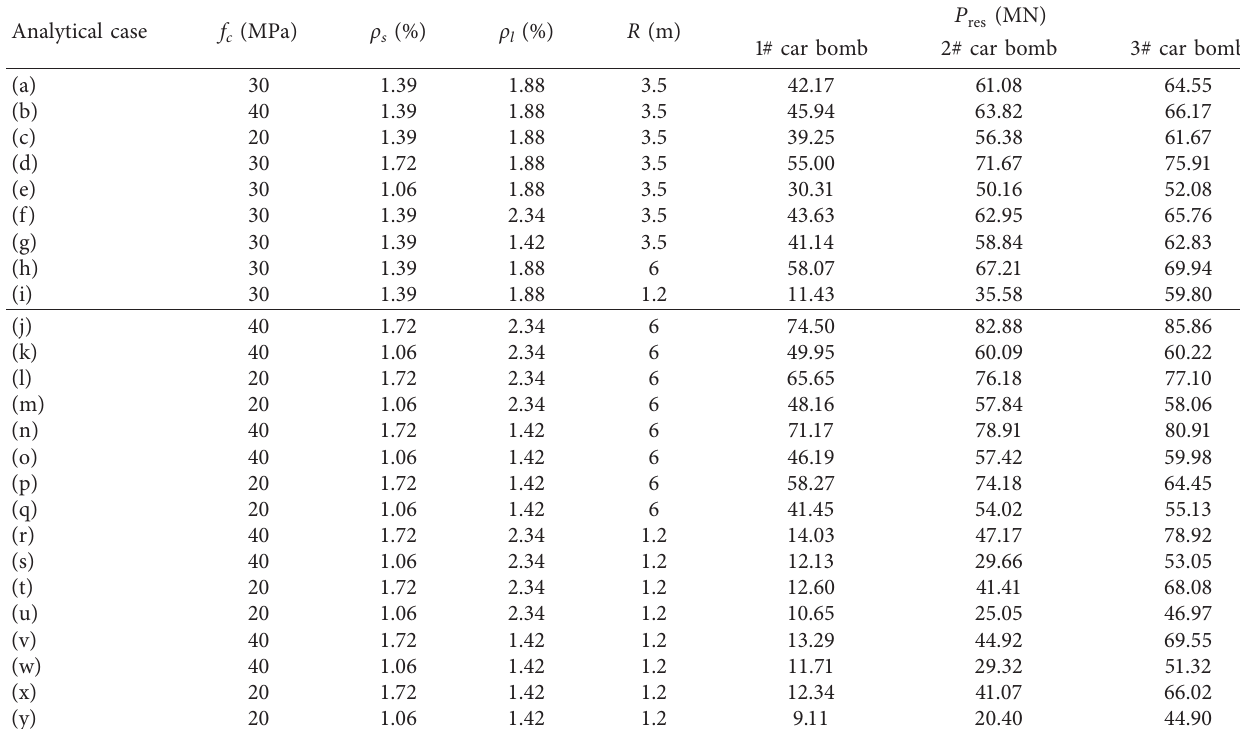
Table 7: Analytical cases based on the CCD